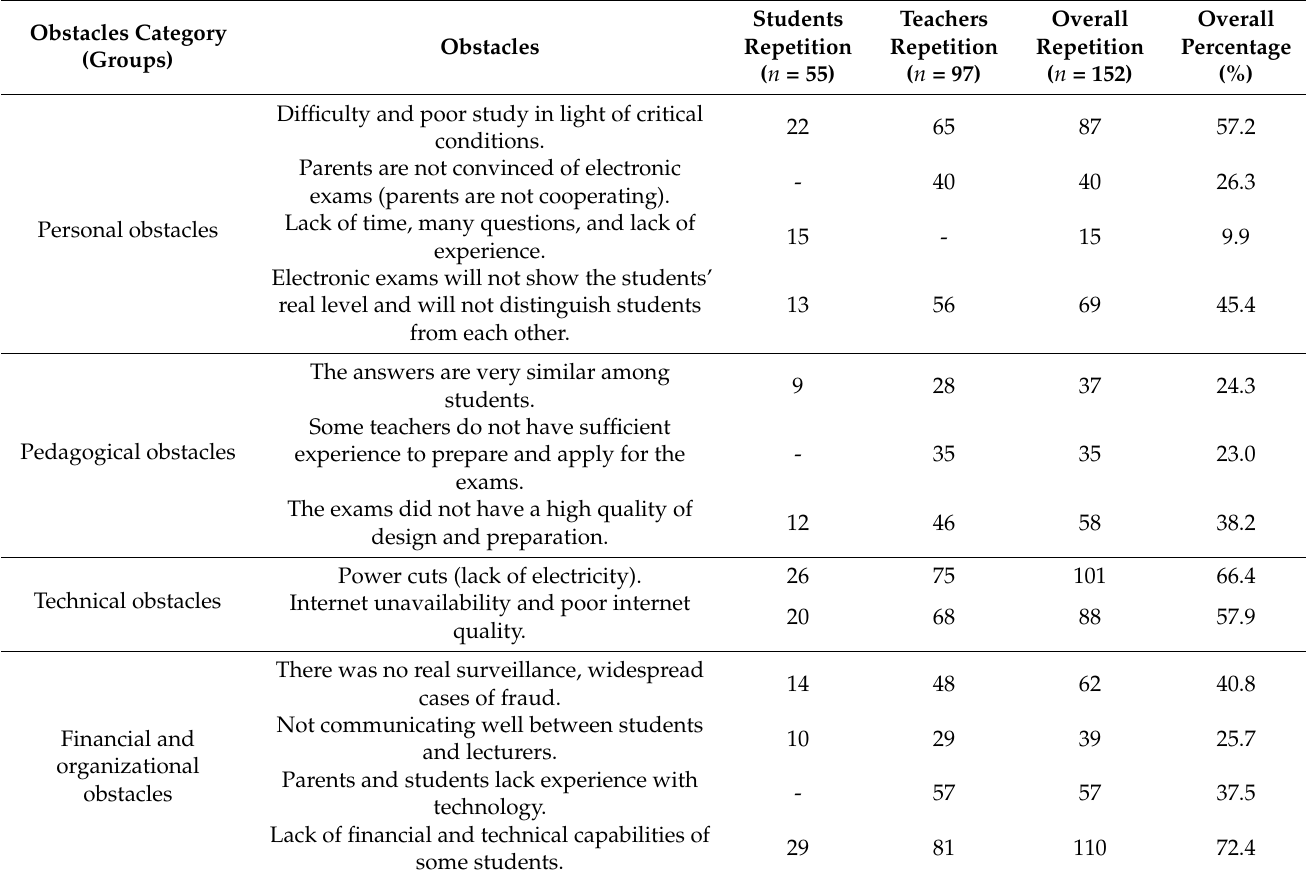
Table 4. Obstacles for the electronic exam under the coronavirus pandemic (a subset of data excerpted from [38]). Obstacles Category (Groups)